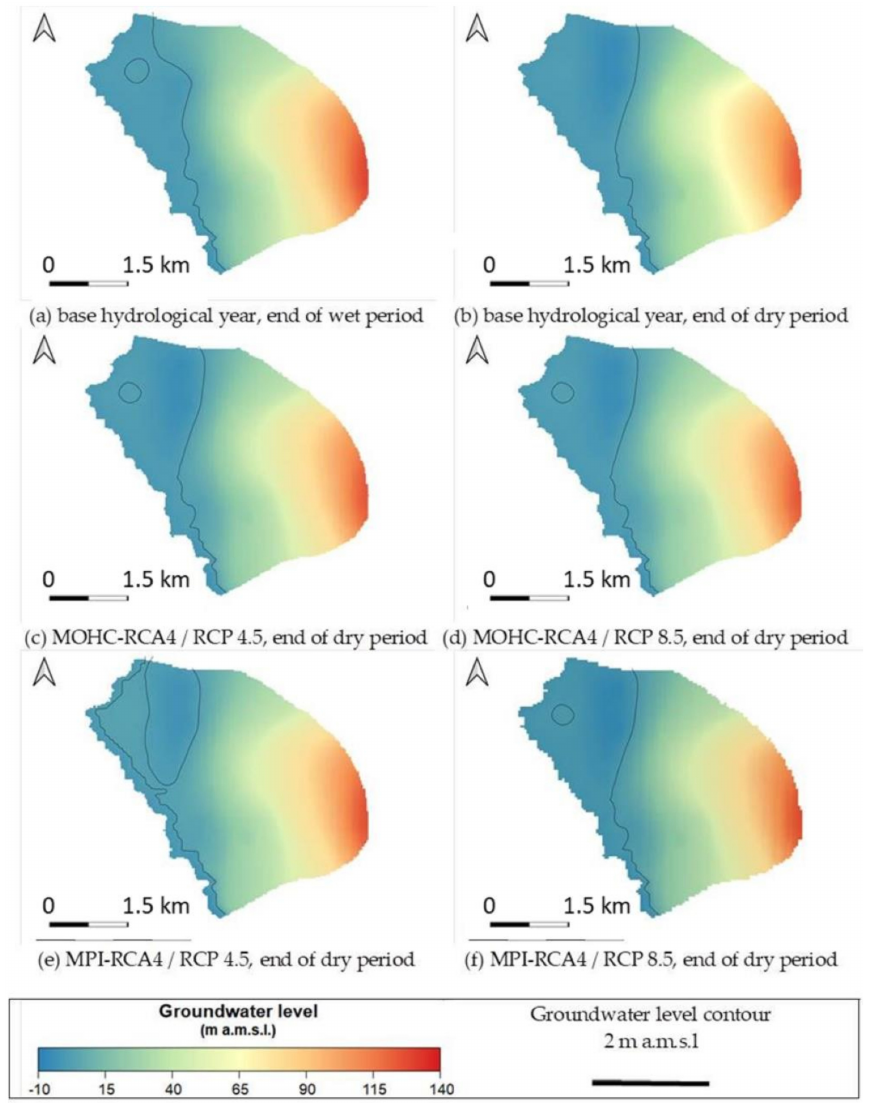
Figure 4. Groundwater level in Pegeia aquifer—Results of numerical simulations.